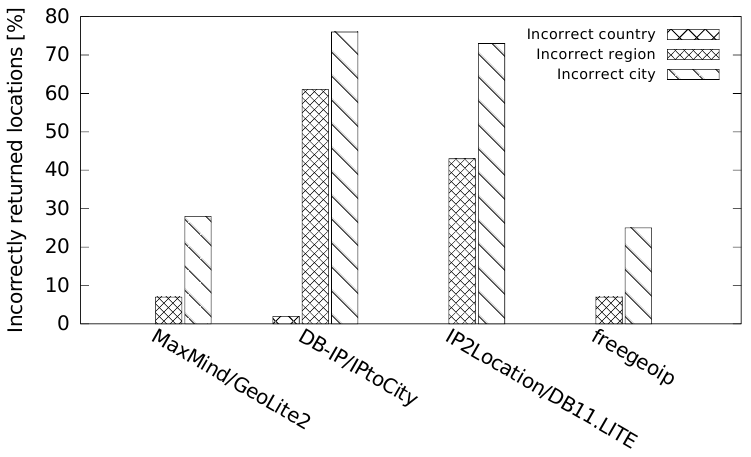
Figure 11. Trustworthiness when providing region or city. Lower percentage means that locations can be trusted